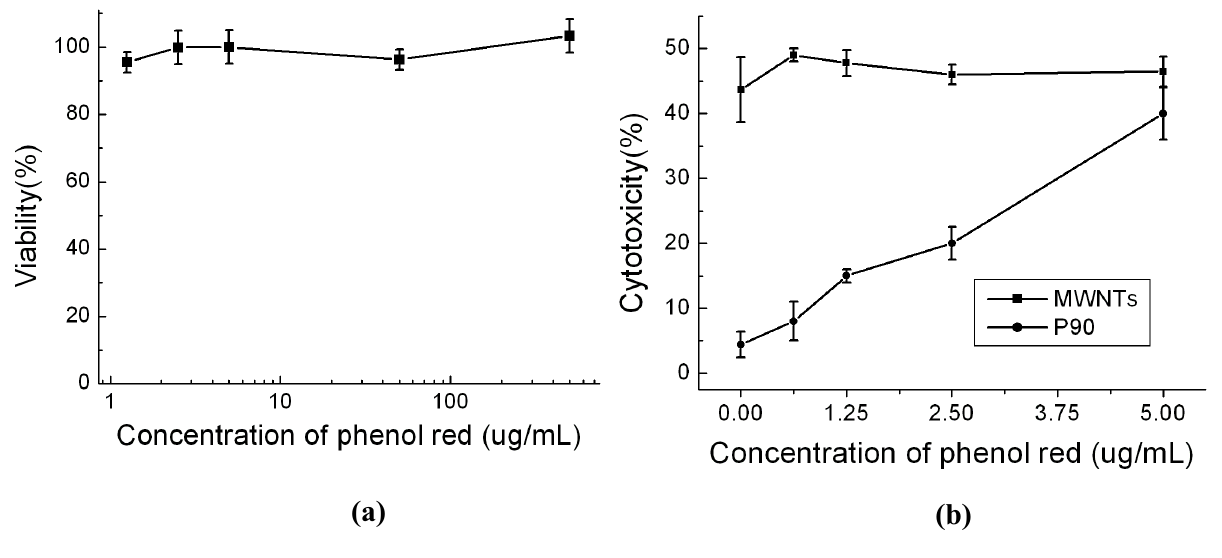
Figure 4. The cytotoxicity of CNPs dispersed in serum-free medium with or without phenol red ( a ) P90; ( b ) MWNTs. All data shown are based on three independent